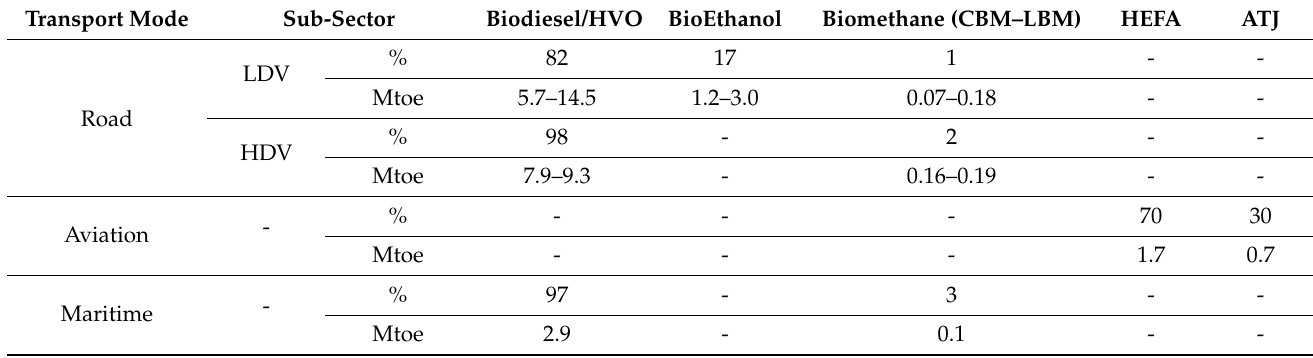
Table 3. Alternative fuel types per transport mode (Mtoe) in 2030.